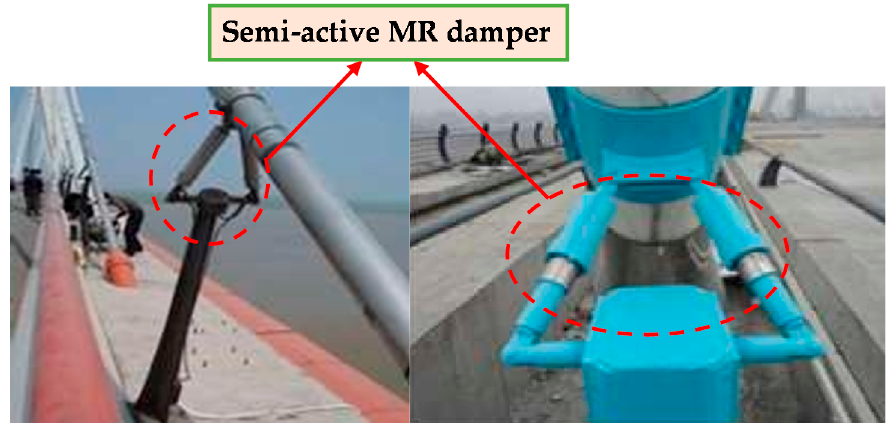
Figure 1. MR damper